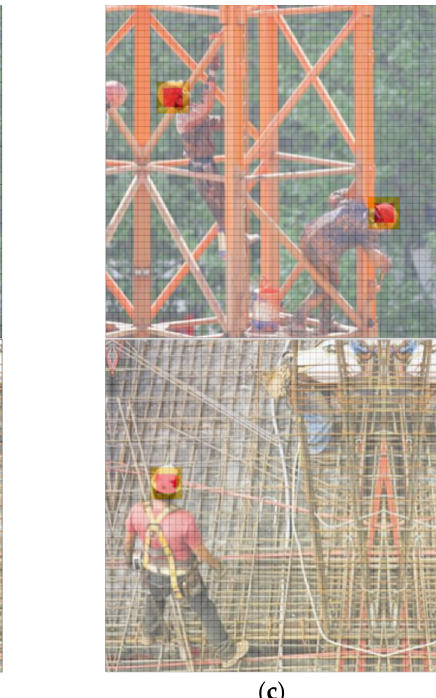
Figure 3. The multi-scale segmentation effect of the sample is shown. The segmentation scales are ( a ) 13 × 13, ( b ) 26 × 26, and ( c ) 52 × 52, respectively.